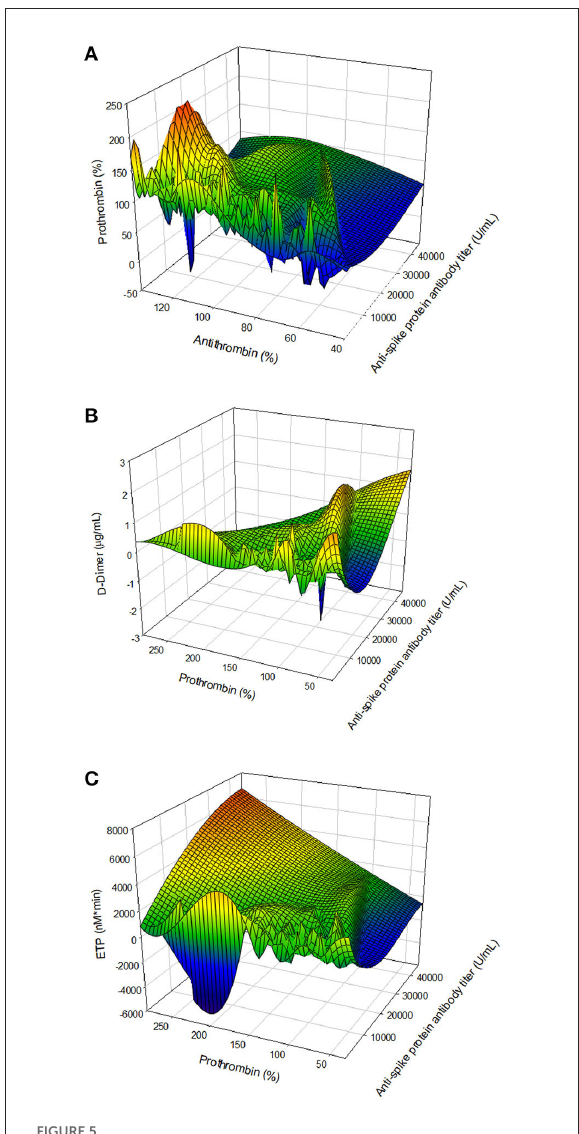
FIGURE5 The association of the anti-SARS-CoV-2 spike protein antibody titer and hemostatic parameters. (A) The relationship antibody titer and coagulation factor levels: antithrombin and prothrombin. (B) The association of antibody titer and coagulation factor consumption: prothrombin and D-dimer. (C) The relation of antibody titer and the thrombin generation potential, quantified by the ETP and prothrombin